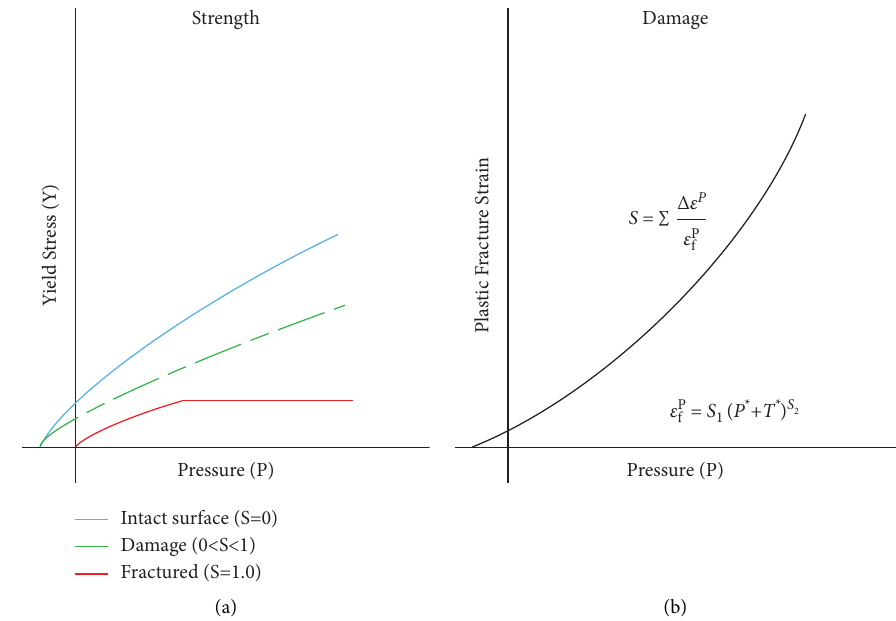
Figure 6: The strength and damage models of the sand and gravel.